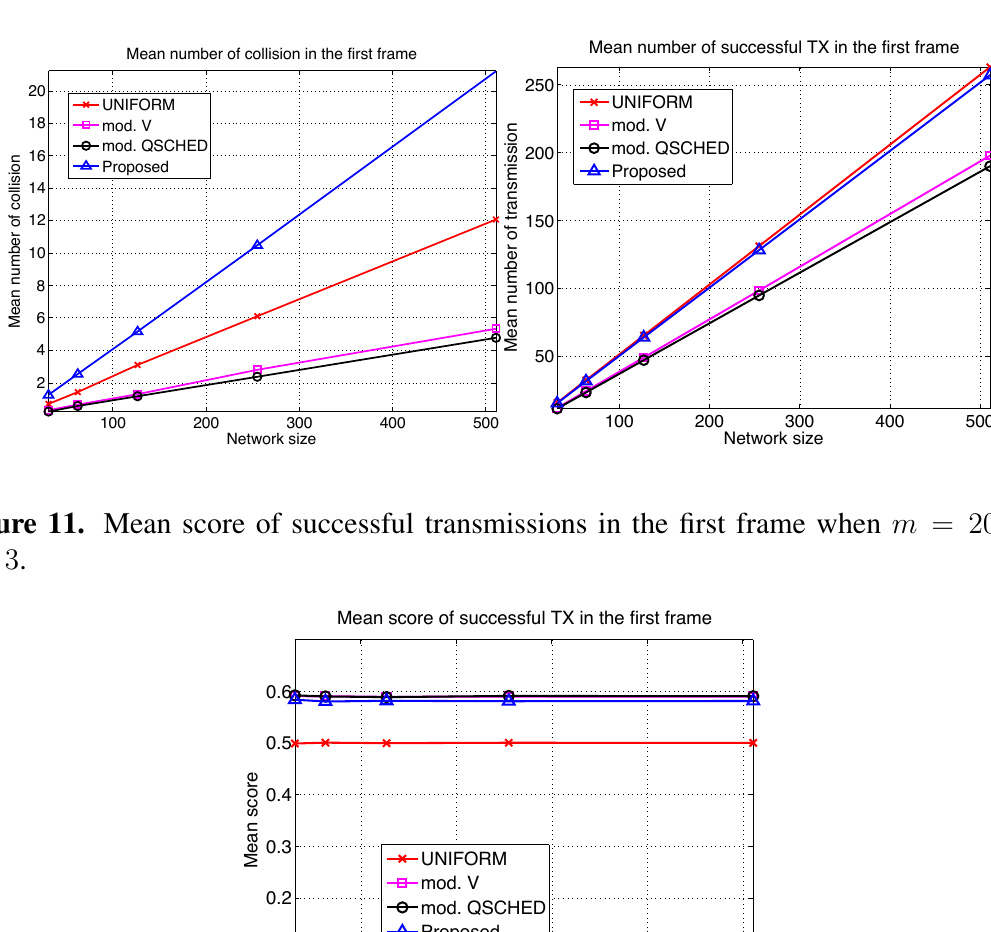
Figure 10. Mean number of collision and successful transmissions in the first frame when m = 30 and b = 3 .